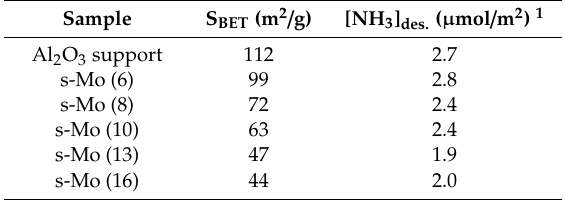
Table 1. Physicochemical characterization data of the supported MoO 3 catalysts.